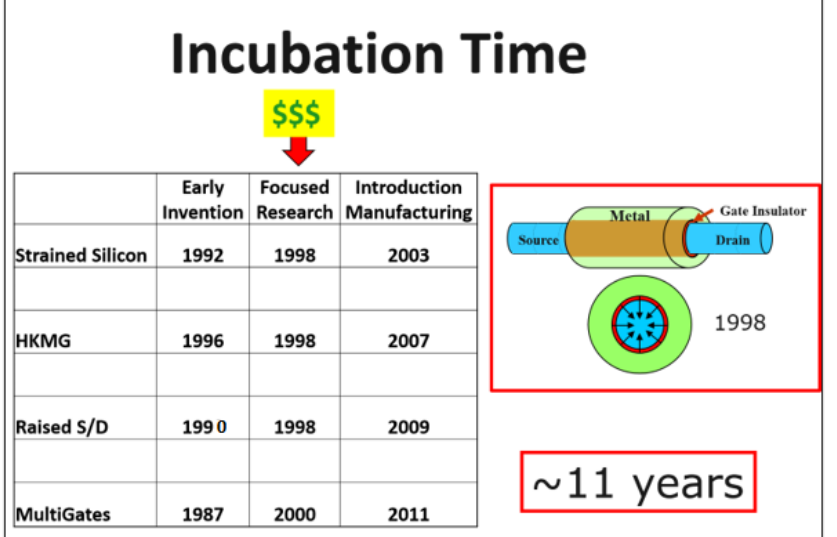
Figure 3. From major innovation to implementation in high-volume: Strained Silicon [8,9], High k/Metal Gate [10], Raised Source/Drain [11], Multi-Gates [12]. In 2013 ITRS the limits of 2D integration were forecasted with dimension of a few nm planed for the 2020s (Figure 4). Flash memories were the first product facing this problem, and in 2014 announcements were made by several companies that they planned to use the third dimension, launching the third generation of transistor scaling (Figure 5).